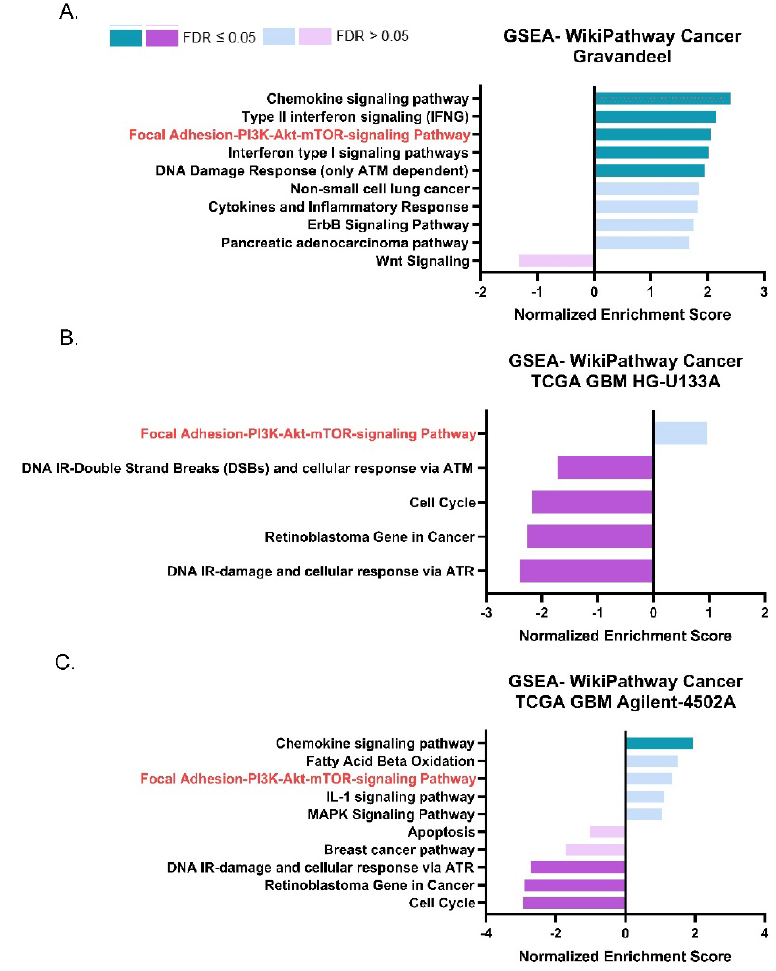
Figure 2. ASAH1 expression positively correlated with genes in the Focal Adhesion-PI3K-AKT- mTOR pathway. Pathway analysis of positive and negative gene correlations to ASAH1 . Datasets were accessed using GlioVis (http://gliovis.bioinfo.cnio.es) (accessed on 12 August 2021). GSEA of r values > 0.3 and < − 0.3 for genes compared to ASAH1 in ( A ) Gravandeel ( B ) TCGA GBM HG-U133A, and ( C ) TCGA GBM Agilent-4502A. Data were analyzed using WebGestalt (http://www. webgestalt.org) (accessed on 12 August 2021) and compared to Wikipathway cancer with a 10 gene minimum/pathway and weighted set